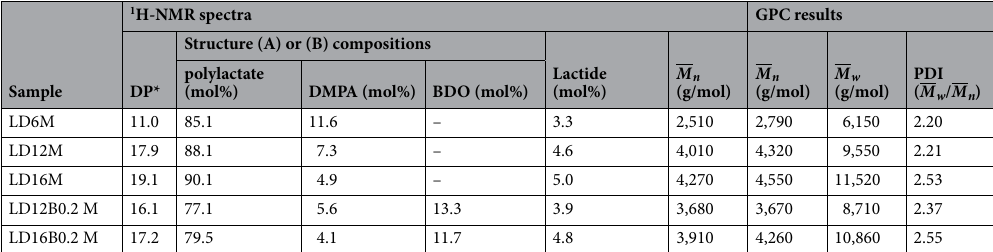
Table 1. Summary of chemical compositions and molecular weights of alcohol-acidolyzed PLA products. *DP is the degree of polymerization.